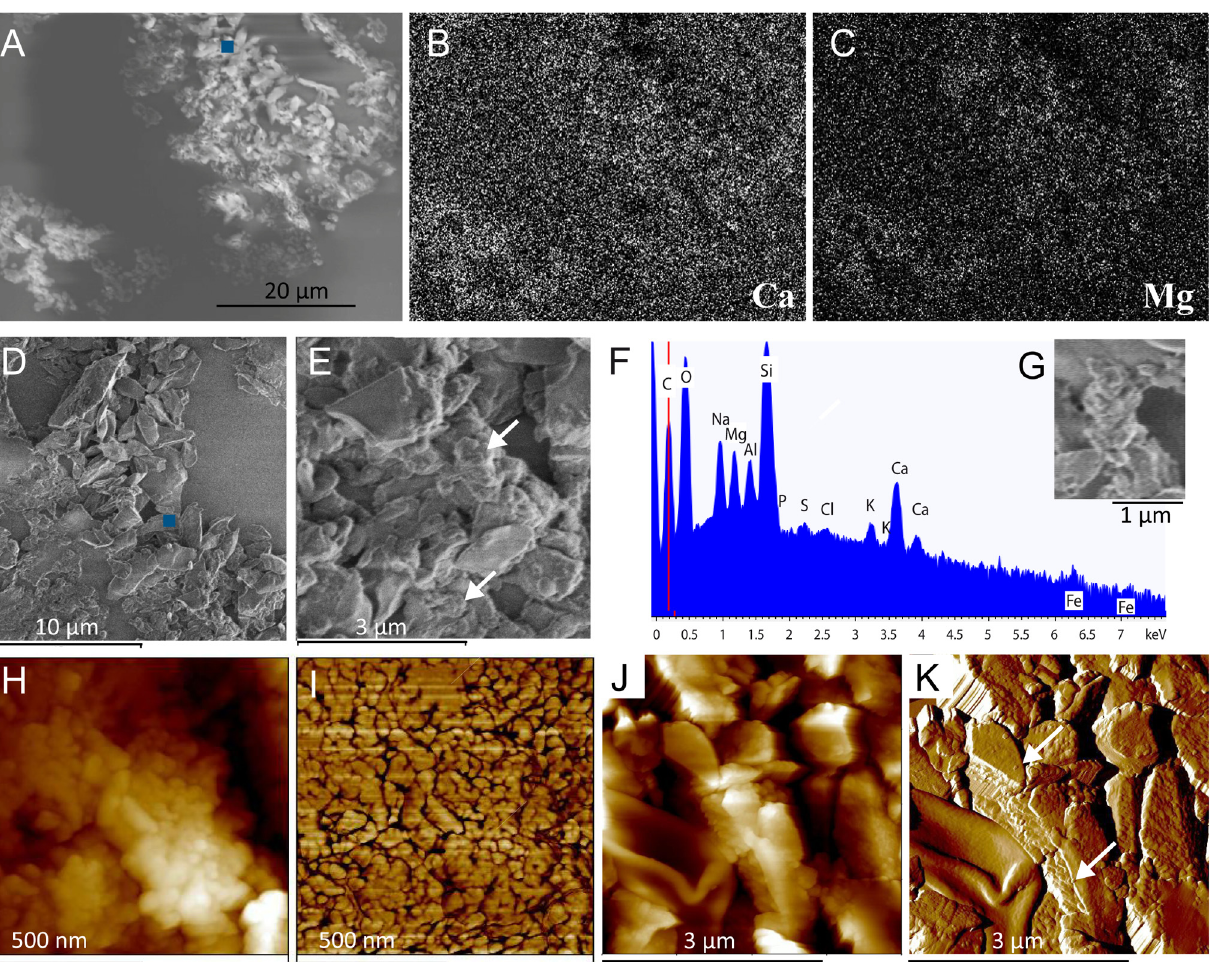
Fig 3. Biogenic calcite, extracted from the microbial mats, observed in scanning electron microscopy linked with energy dispersive X-ray spectrometry and in atomic force microscopy. A: SEM picture of a cross section of carbonate grains showing a surface area of about 50 × 40 µ m cutting through two agglomerates of very small globules and large crystals. B and C: Maps of calcium (B) and magnesium (C) obtained by EDS analysis in the same area. D-E: High-resolution images showing the variety in size and shape of mineral grains and crystals that compose biogenic calcium carbonate agglutinates. The arrows point towards smaller agglomerates of roundish micro-grains. F: EDS spectrum of the (Ca,Mg)CO 3 grain for the location indicated by the blue dots in A and D (note that the high Si peak, due to the glass slide, masks the Si present in the clay colloids which also comprise Al and K). G: Details of an agglomerate of roundish micro-grains showing micromorphologies of very small rounded globules. H, I: AFM (in intermittent contact mode) images of a 1 × 1 µ m surface area showing the globular structure of the individual (Ca,Mg)CO 3 micro-grains and presented as height (H) and phase (I) images. J, K: AFM images of a 4 × 4 µ m surface area in the cross section in AFM showing topography (J) and phase (K) images at a magnification comparable to that used for SEM. White arrows point to viruses that have been studied at higher magnification, i.e., the viruses illustrated in Fig 4D –